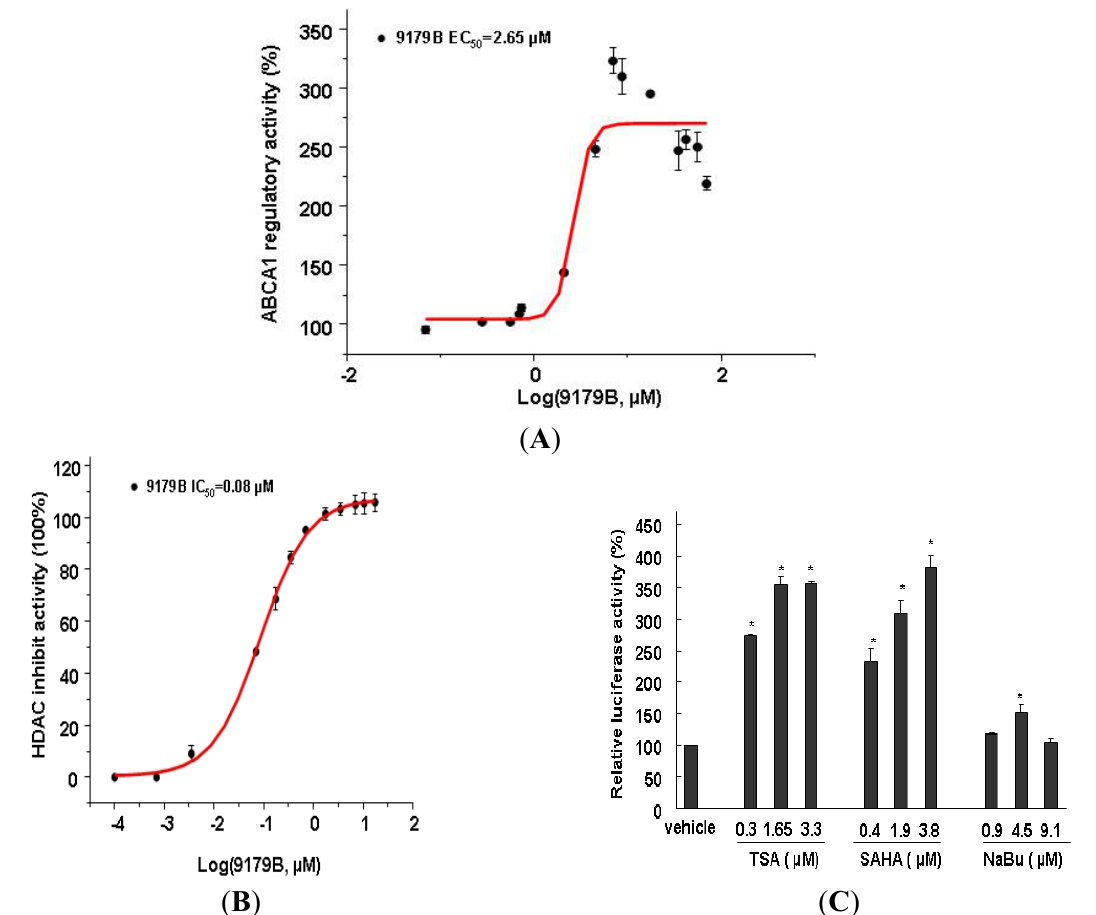
Figure 2. The effect of 9179B and other HDAC inhibitors on ABCA1 promoter